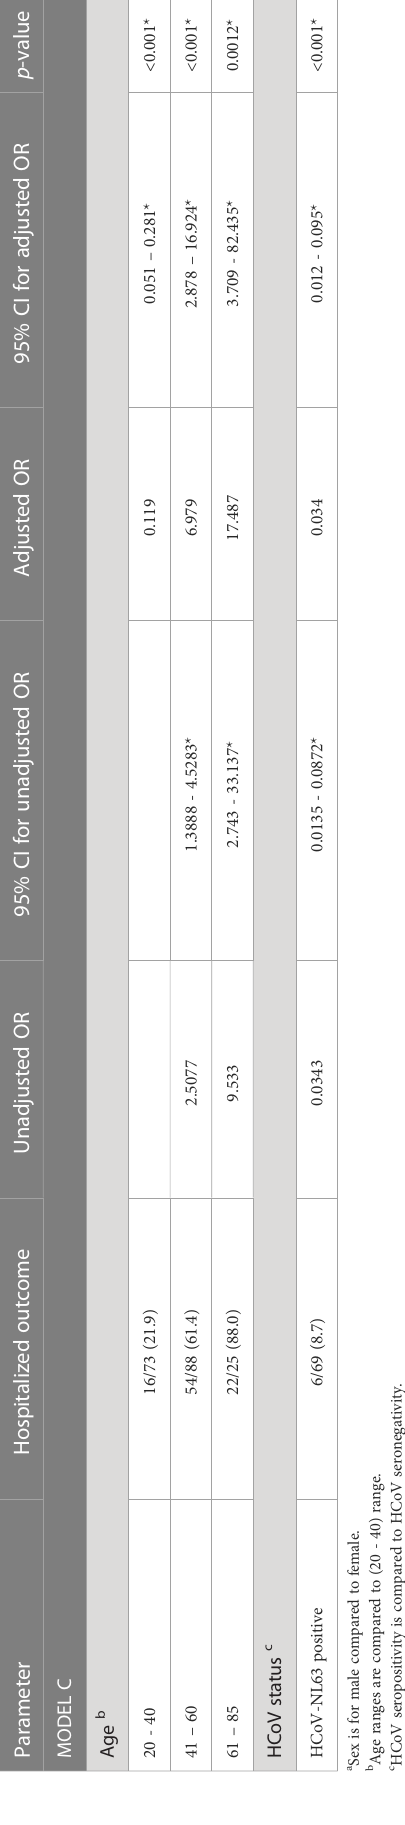
adjusted OR = 7.3239 (95% CI: 1.8195 – 29.4800)], male sex [Table 2, Model B, p = 0.0467, adjusted OR = 2.5242 (95% CI: 1.0136 – 6.2862)], age range between 40 - 61 years [Table 2, Model B, p <0.001, adjusted OR = 7.2237 (95% CI: 2.7511 – 18.9680)] and age range between 61 - 85 years [Table 2, Model B, p = 0.0012, adjusted OR = 12.5092 (95% CI: 2.7022 – 57.9072)] were associated with increased COVID-19 severity (risk factors). The protective association of previous exposure with HCoV-NL63 also remained signi fi cant when only adjusted for age [Table 2, Model C, p